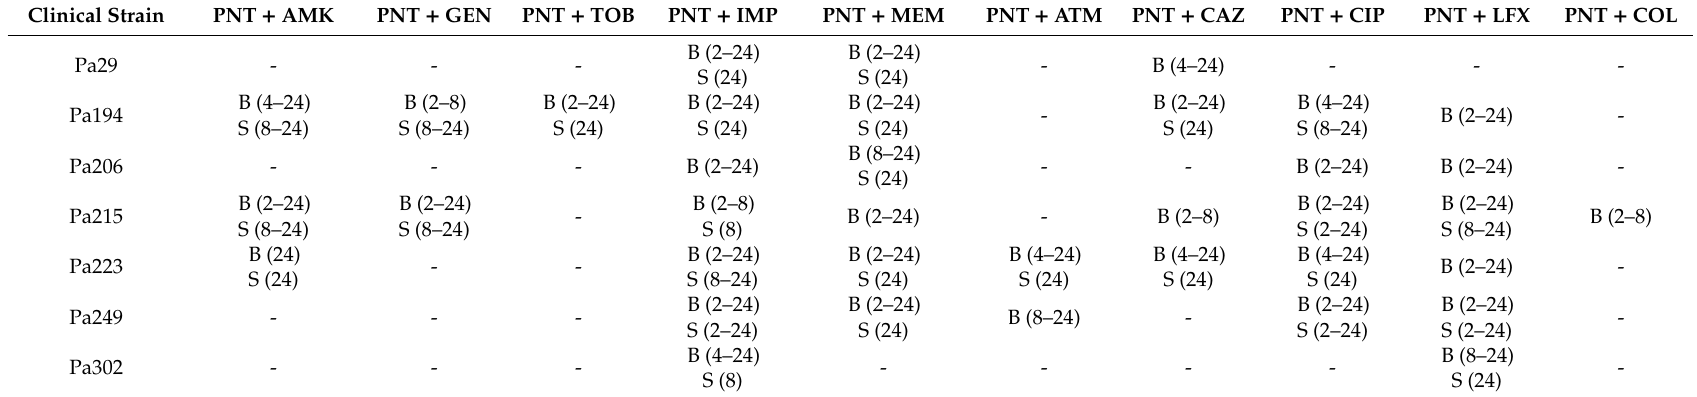
Table 3. Synergistic and bactericidal activities of pentamidine in combination with antibiotics against the seven Pseudomonas aeruginosa clinical